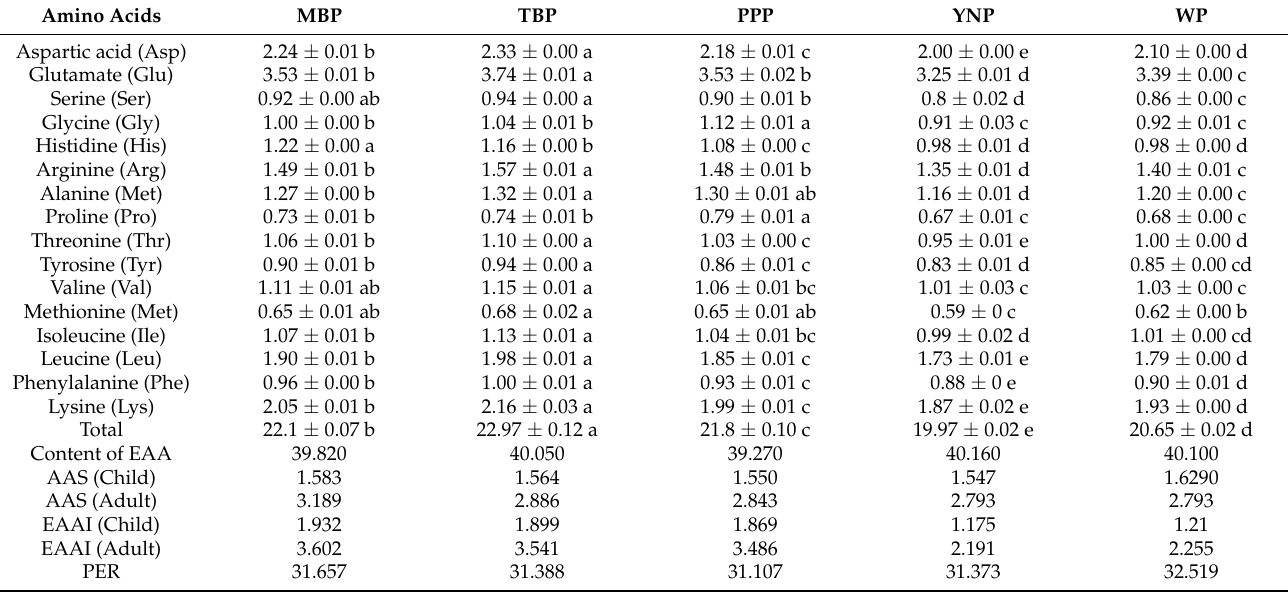
Table 4. Content of hydrolyzed amino acids of pork (g/100 g).